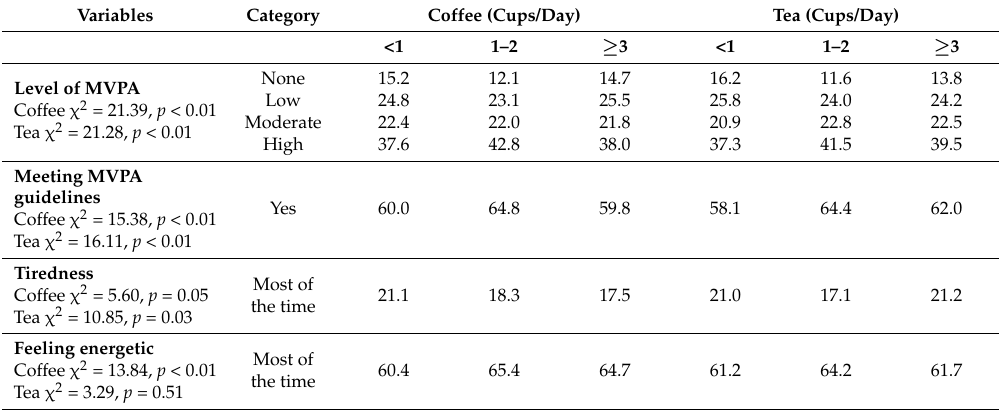
Table 2. Percentage of participants in each category of coffee and tea consumption and level of moderate-to-vigorous physical activity (MVPA), tiredness, and energy ( n = 7580). Variables Category Coffee (Cups/Day) Tea (Cups/Day)